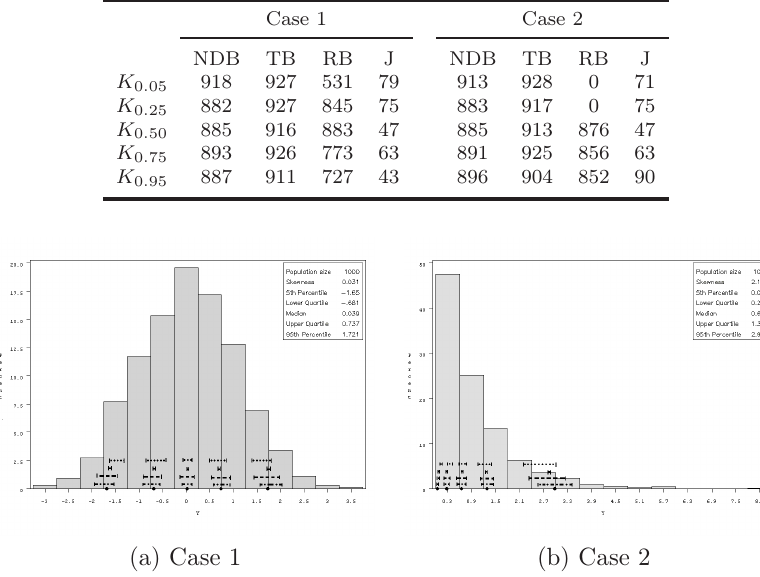
Table 1. The number of coverage of 90% confidence intervals for 1000 samples.